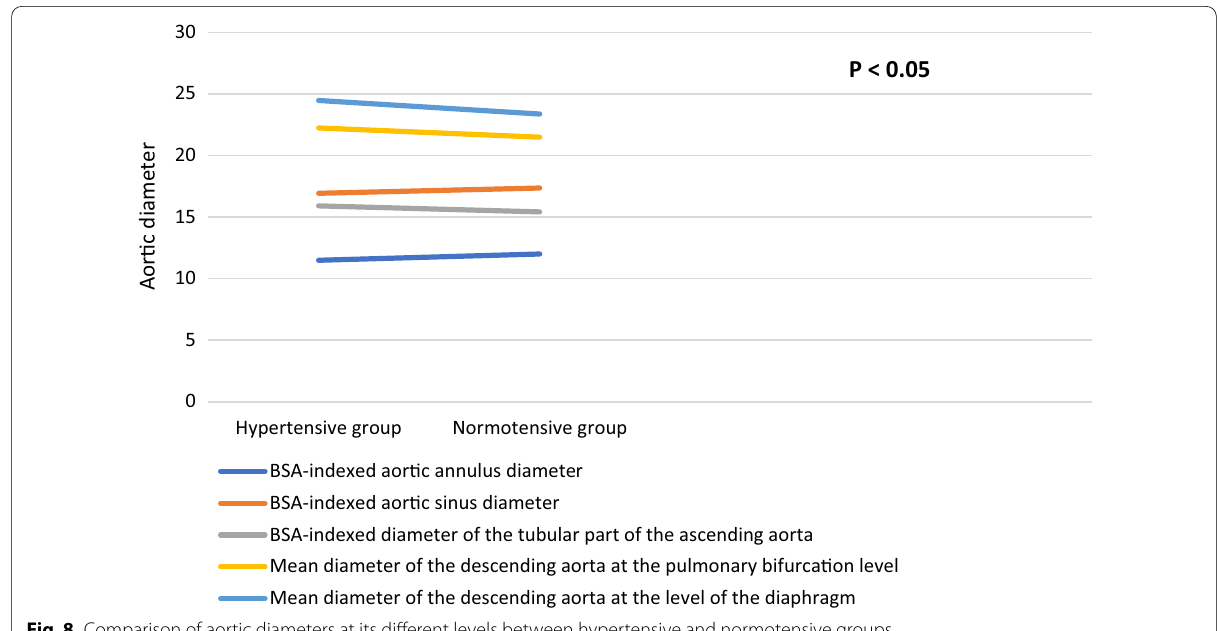
Fig. 8 Comparison of aortic diameters at its different levels between hypertensive and normotensive groups Table 18 Comparison of descending thoracic aorta diameters in normotensive and hypertensive individuals